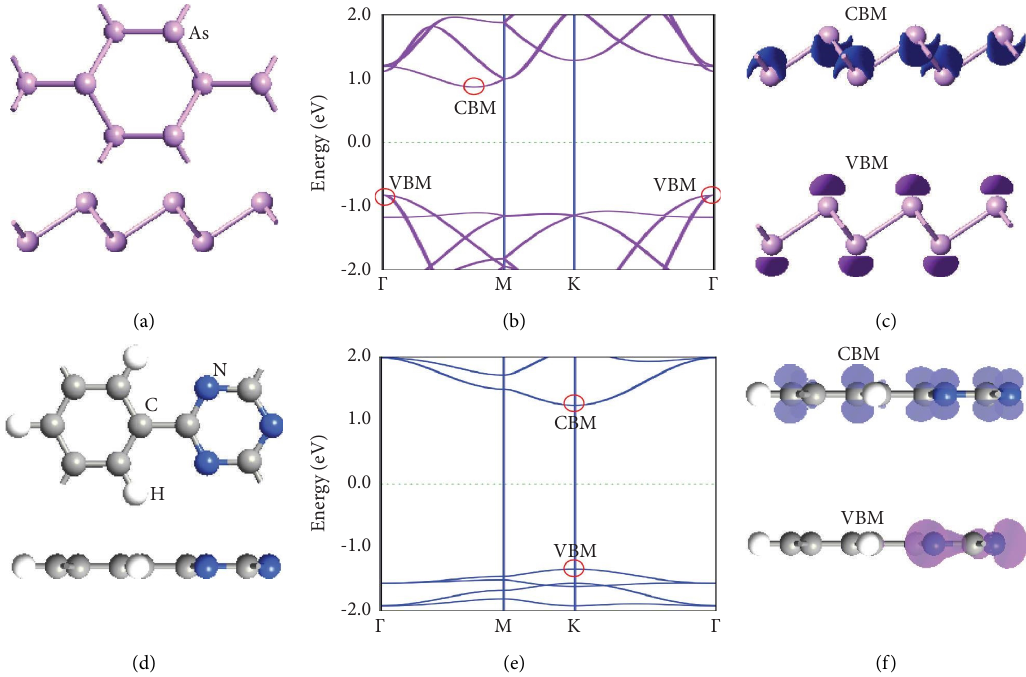
Figure 1: (a) Top and side perspectives of atomic structures, (b) band structure and (c) charge-density iso-surfaces of CBM and VBM states of monolayer As. (d) Top and side perspectives of atomic structures, (e) band structure and (f) charge-density iso-surfaces of CBM and VBM states of monolayer CTF.